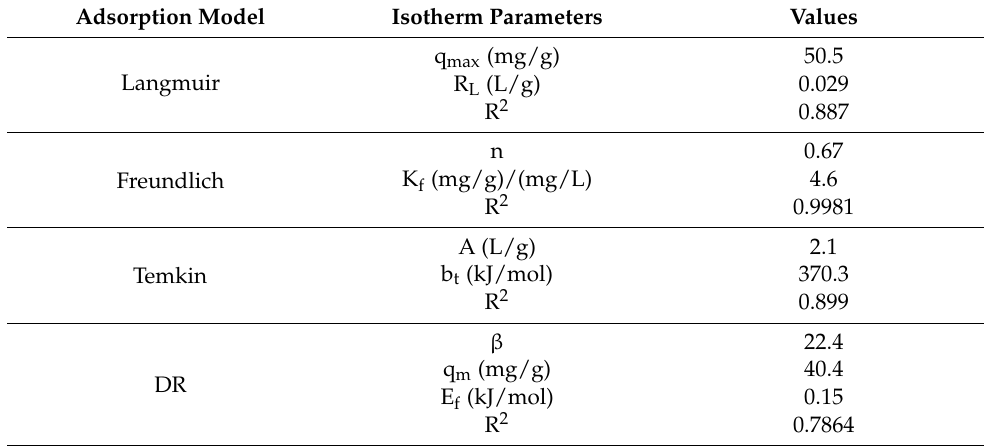
Figure 11. Adsorption isotherm: ( a ) Langmuir; ( b ) Freundlich; ( c ) Temkin; ( d ) DR models. Table 2. Parameters of the adsorption isotherm